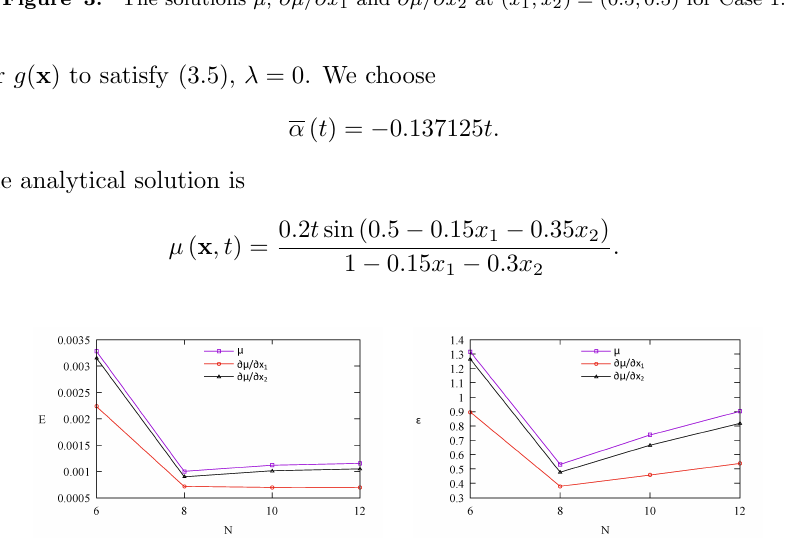
Figure 4. The aggregate relative error E and efficiency number ε = τE for Case 2. Figure 4, Tables 4 and 5 show that for solutions µ, ∂µ/∂x 2 the smallest error E and efficiency number ε are achieved, when N = 8, whereas for the solutions ∂µ/∂x 1 they are reached, when N = 12 and N = 8